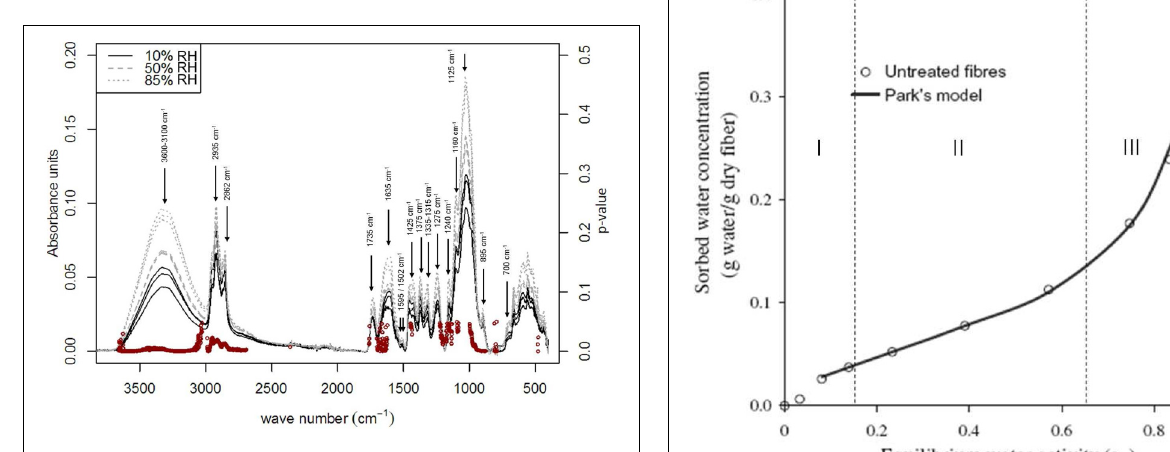
FIGURE 5 | Infrared spectra bands impacted by increasing relative humidity for sisal fiber. p -values scores (used with a threshold of 0.05), indicating significant impact of the water uptake on the FTIR bands, were marked using red dots (Célino et al., 2013, 2014a,b).